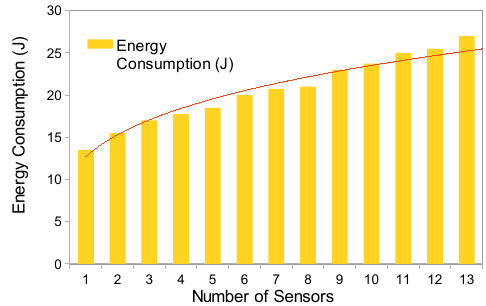
Figure 19. Energy Consumption - MOSDEN Client (Sensing)